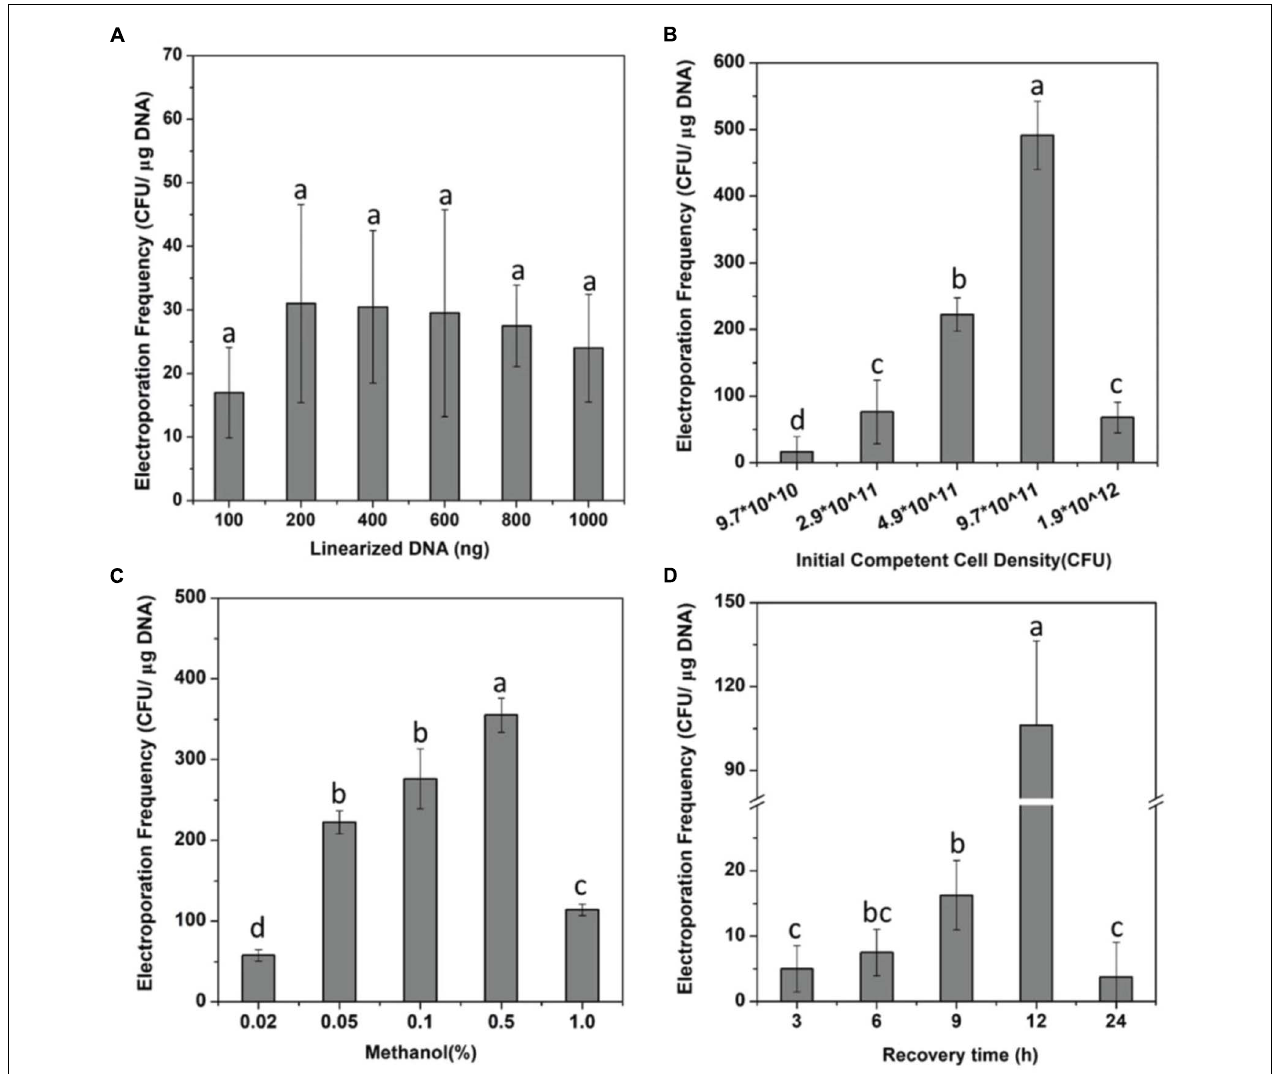
FIGURE 1 | Optimization of the electroporation system. (A) Effect of the number of linearized DNA fragments on the electroporation efficiency of strain Methylomicrobium buryatense 5GBlS (cid:49) fadE . (B–D) Effects of the cell density (B) , methanol concentration (C) , and the recovery time (D) on the electroporation efficiency of strain Methylomicrobium buryatense 5GB1S. Lowercase letters above bars indicate significant differences ( P <